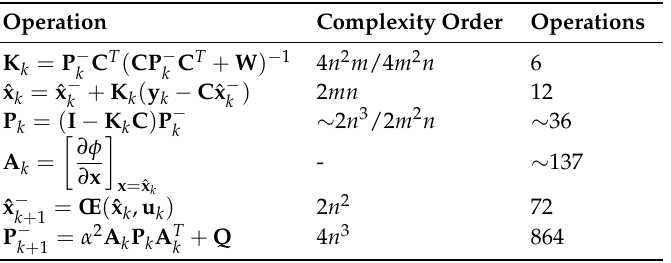
Table 1. Extended Kalman filter (EKF) complexity depending on n , q and p .